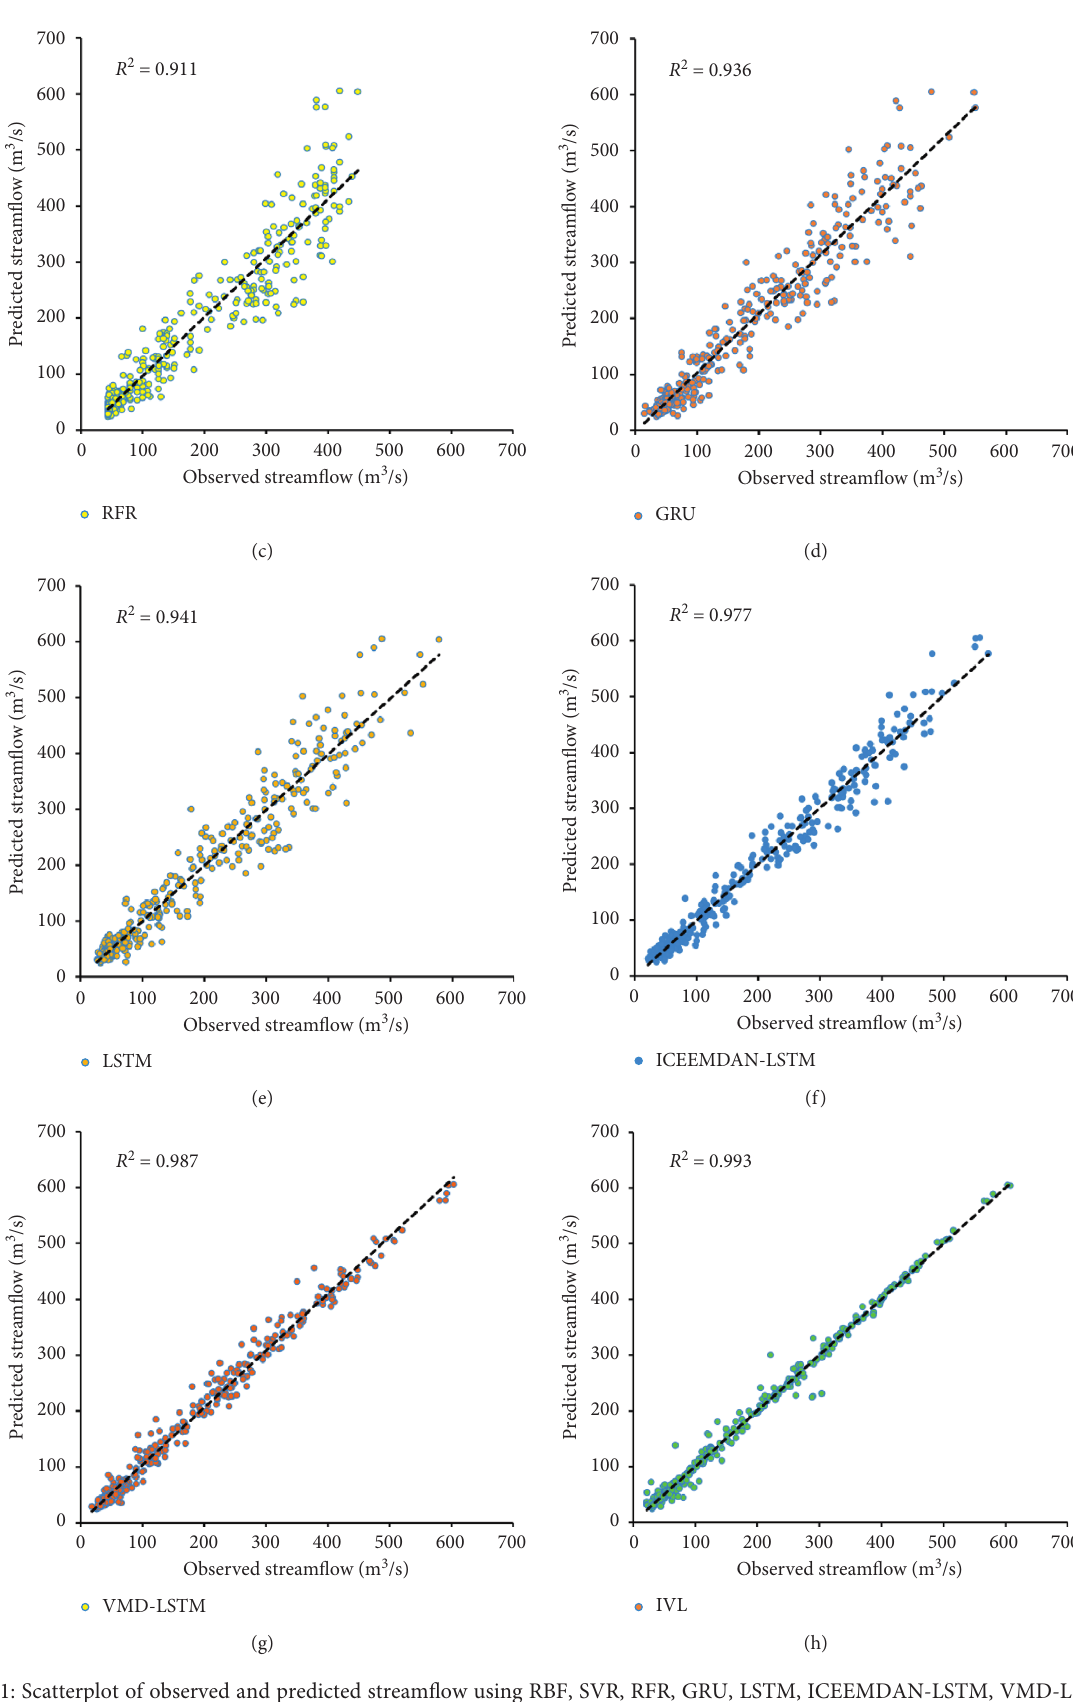
Figure 11: Scatterplot of observed and predicted streamflow using RBF, SVR, RFR, GRU, LSTM, ICEEMDAN-LSTM, VMD-LSTM, and IVL models for the training